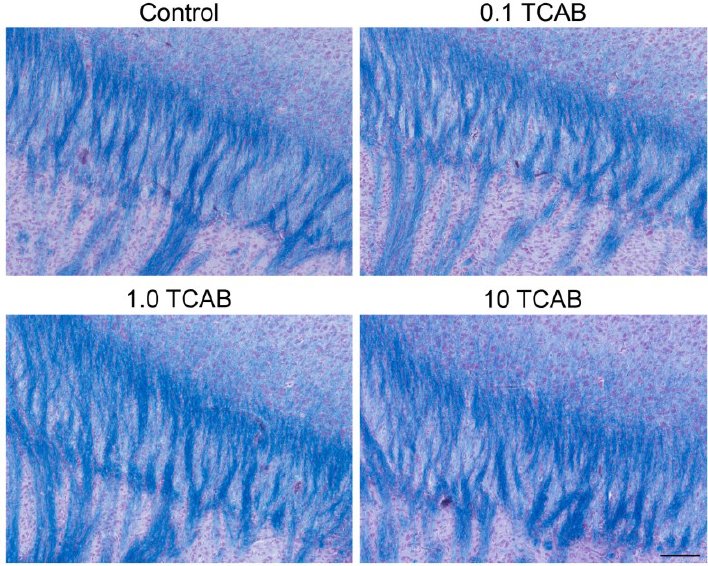
Figure 8. Myelin. Representative solochrome staining of myelin (blue) in the corpus callosum at PND21. A normal pattern and density of staining with no visual differences observed as a function of developmental 3,3',4,4'-tetrachloroazobenzene (TCAB) exposure. Scale bar = 50